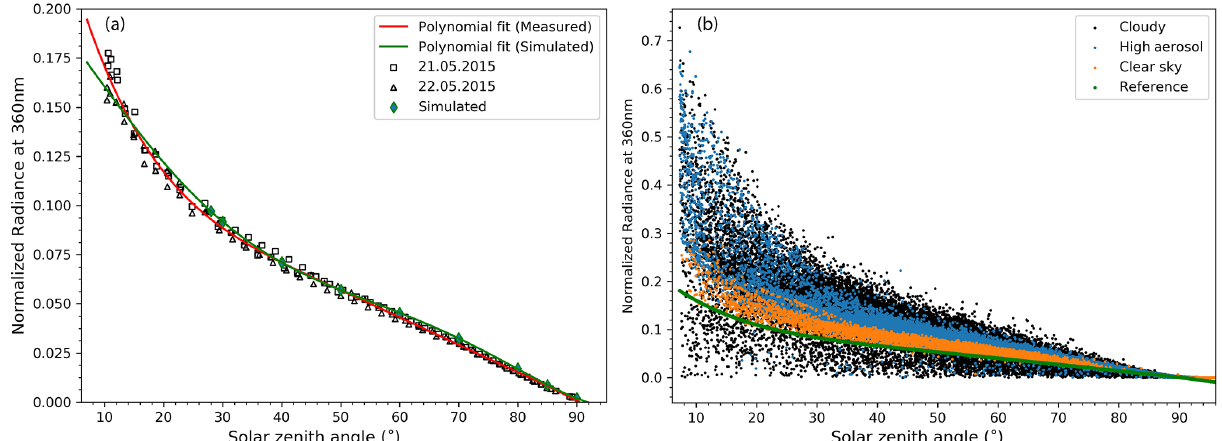
Figure B2. Dependence of the measured and simulated radiances in zenith direction (at 360nm) on the solar zenith angle for the 2 selected days (a) . Panel (b) shows all measured normalized radiances (after calibration) in zenith direction, colour-coded for three sky conditions: black – cloudy sky; orange – clear sky with low aerosol load; blue – clear sky with high aerosol load. All measurements corresponding to thick clouds lie below the threshold (shown as green curve) in (b)